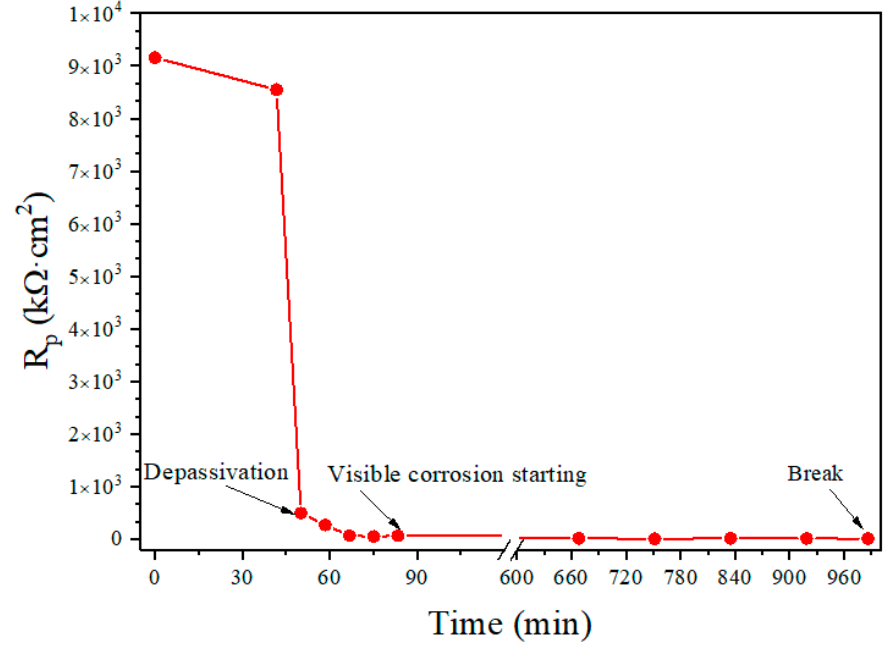
Figure 4. Time-history of R p value and key time points for depassivation, corrosion initiation and final break ( F = 42 N, 7-day passivation, Cl − = 0.025 mol/L, pH = 10.3).